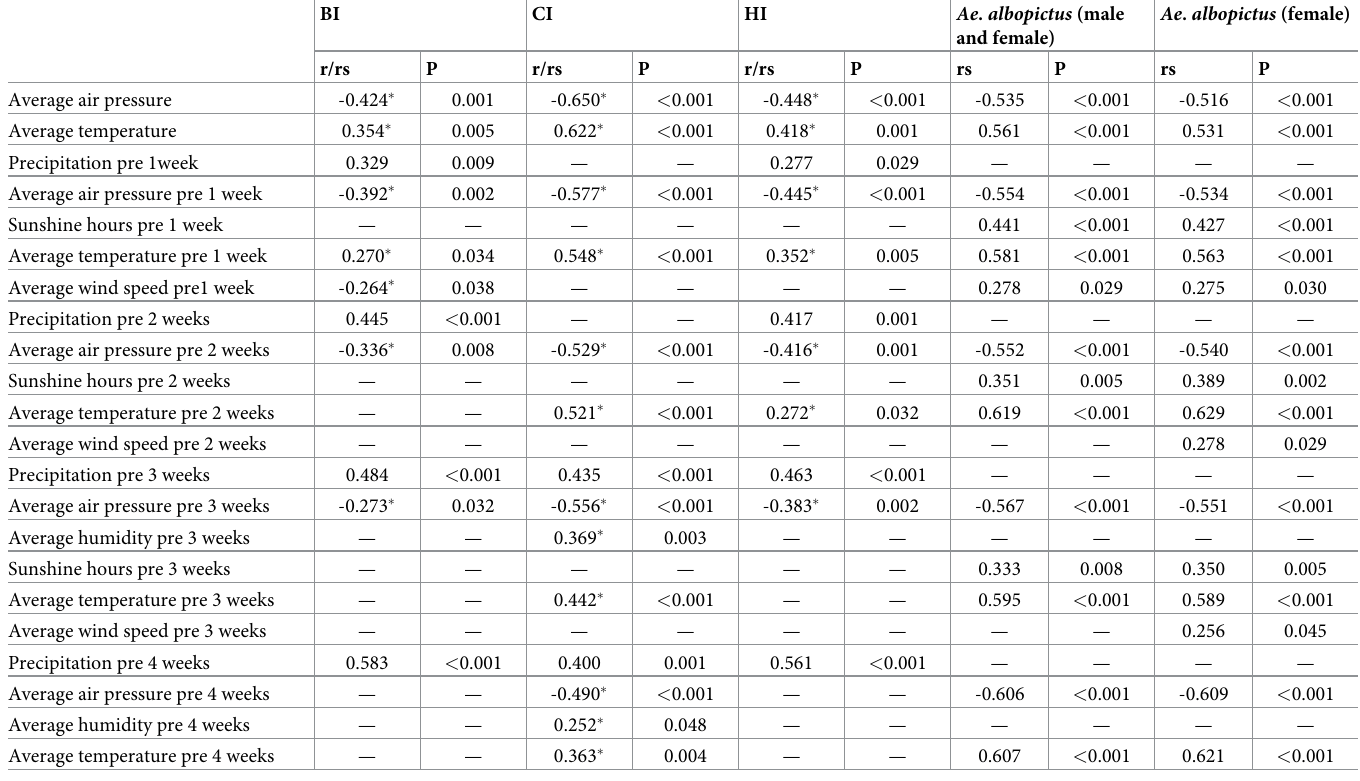
Table 2. The correlations between the mosquito density and the meteorological